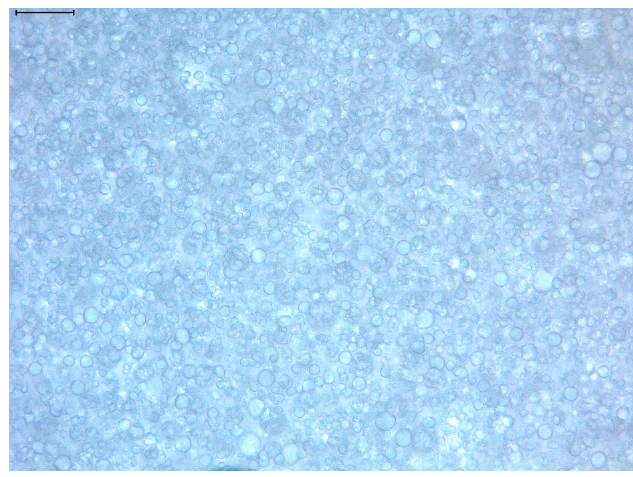
Figure 2. Droplets of the internal oil phase in the O/W emulsion. Bar corresponds to 10 µm. Magnification 100×.